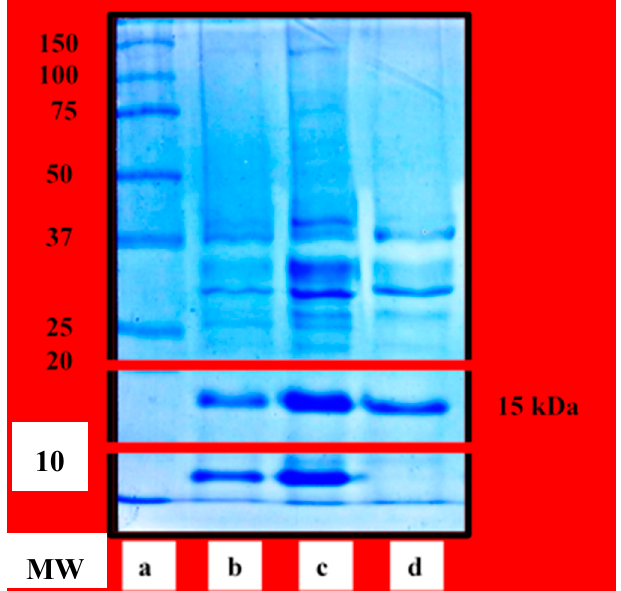
Figure 1. SDS-PAGE profiles for the ‘Señorita’ banana protein extract: ( a ) protein marker and their corresponding molecular weights in kDa; ( b ) 167 µ g/mL crude protein extract; ( c ) 964 µ g/mL partially purified protein extract; and ( d ) 152 µ g/mL purified protein extract. The electrophoresis was done in a 15% gel and run at 110V for 60 min. Highlighted band: Major proteins/Protein of interest.